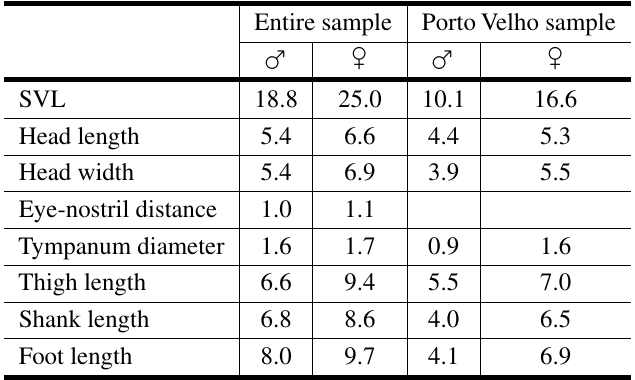
Ranges (maximum-minimum values) of measurement variables for male and female Leptodactylus podicipinus . Values in mm. Entire sample Porto Velho